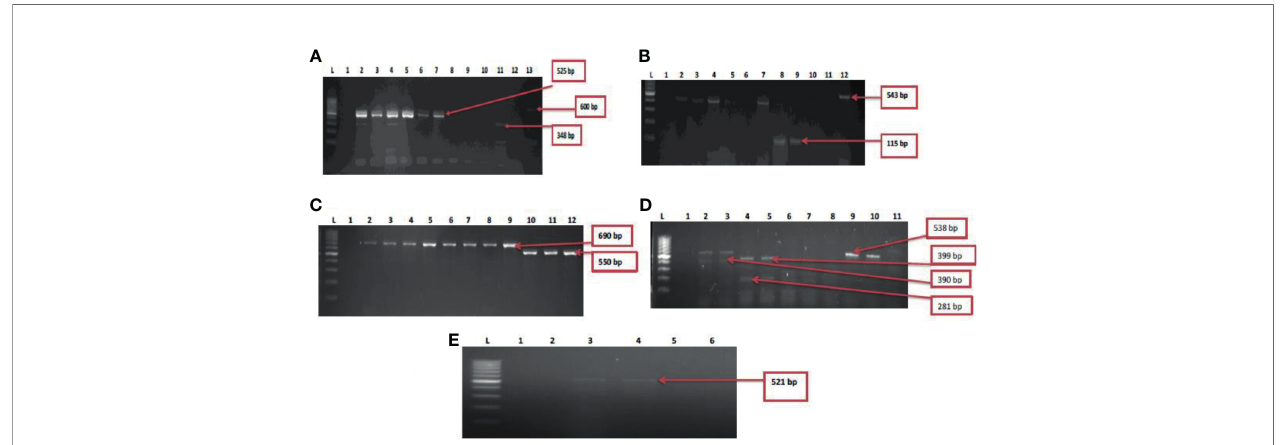
FIGURE 5 | (A) = Gel multiplex electrophoresis showing the aphA1, aadA and strA genes among the Vibrio species. Lane L: Molecular Marker (100 bp), lane 1: Negative control; Lane 2-7: positive isolates of aadA gene (525 bp). Lane 11: positive isolate of strA gene (348 bp) and lane 13: positive isolate of aphA1 gene (600 bp), (B) = Gel multiplex electrophoresis showing the cmlA1 and catII genes among the Vibrio species. Lane L: Molecular Marker (100 bp), lane 1: Negative control; Lane 2-5, 7, 10 and 12: positive isolates of catII gene (543 bp). Lane 8 and 9: positive isolate of cm/A/ gene (115 bp), (C) = Gel multiplex electrophoresis showing the blaTEM and ampC genes among the Vibrio species. Lane L: Molecular Marker (100 bp), lane 1: Negative control; Lane 2-9: positive isolates of bla TEM gene (690 bp). Lane 10-12: positive isolate of ampC gene (550 bp), (D) = Gel multiplex electrophoresis showing the bla KPC , bla GES , bla VIM and bla OXA - 48 genes among the Vibrio species. Lane L: Molecular DNA-Marker (100 bp), lane 1: Negative control; Lane 2, 3, 9 and 10: positive isolates of bla KPC gene (543 bp). Lane 4 and 5: positive isolate of bla GES gene (399 bp). Lane 2 and 3: positive bla VIM isolates (390 bp). Lane 4 and 5: positive isolates of bla OXA-48 (281 bp), (E) = Gel electrophoresis showing the qnr VC genes among the Vibrio species. Lane L: Molecular DNA-marker (100 bp), lane 1: Negative control; Lane 3 and 4: positive isolates of qnr VC gene (521 bp).